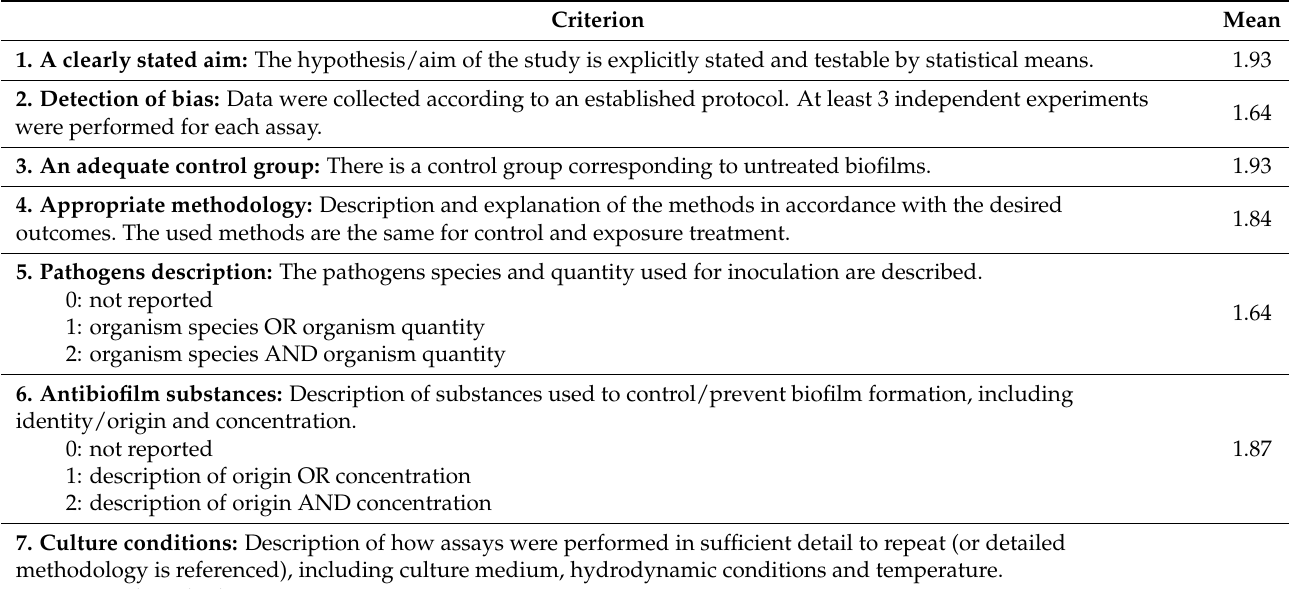
Table 4. Methodological index for in vitro studies and the respective mean of all